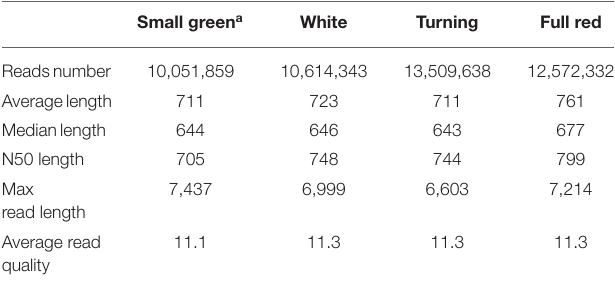
TABLE 1 | Full-length non-chimeric transcripts of the Oxford nanopore sequencing